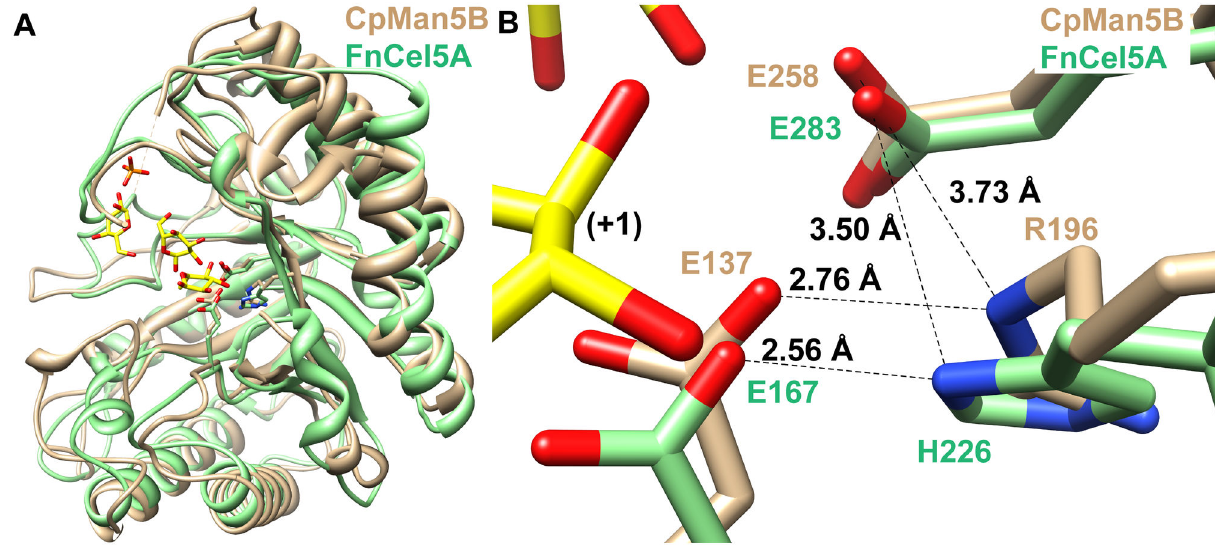
Figure 6. Structural comparison of CpMan5B with Fervidobacterium nodosum Rt17-B1 endoglucanase (FnCel5A). A, The FnCel5A enzyme (PDB ID: 3RJY) bound to three glucose molecules (yellow and red heteroatoms) and phosphate (orange and red heteroatoms) is superimposed onto CpMan5B (tan). B, Close-up view of the proposed catalytic triad. The figure is drawn in the same orientation as in A. Sugar subsite is indicated in black font. doi: